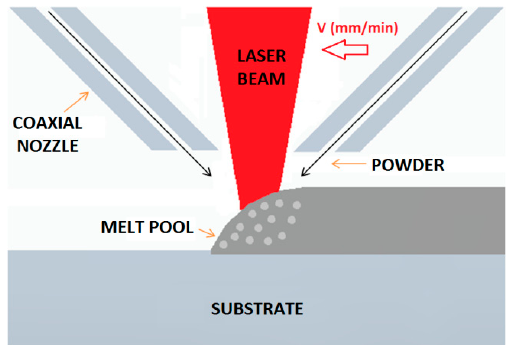
Figure 1. Schematic layout of the coaxial laser cladding system.